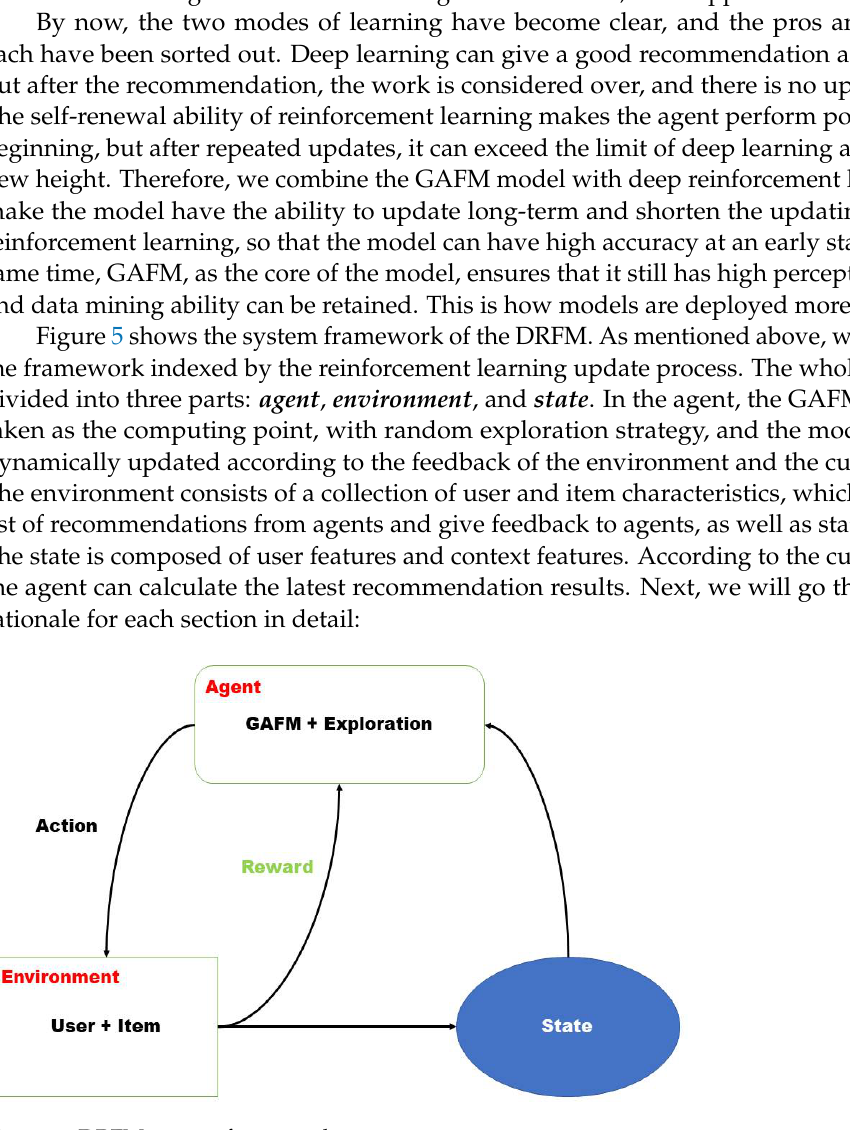
Figure 5. DRFM system framework.